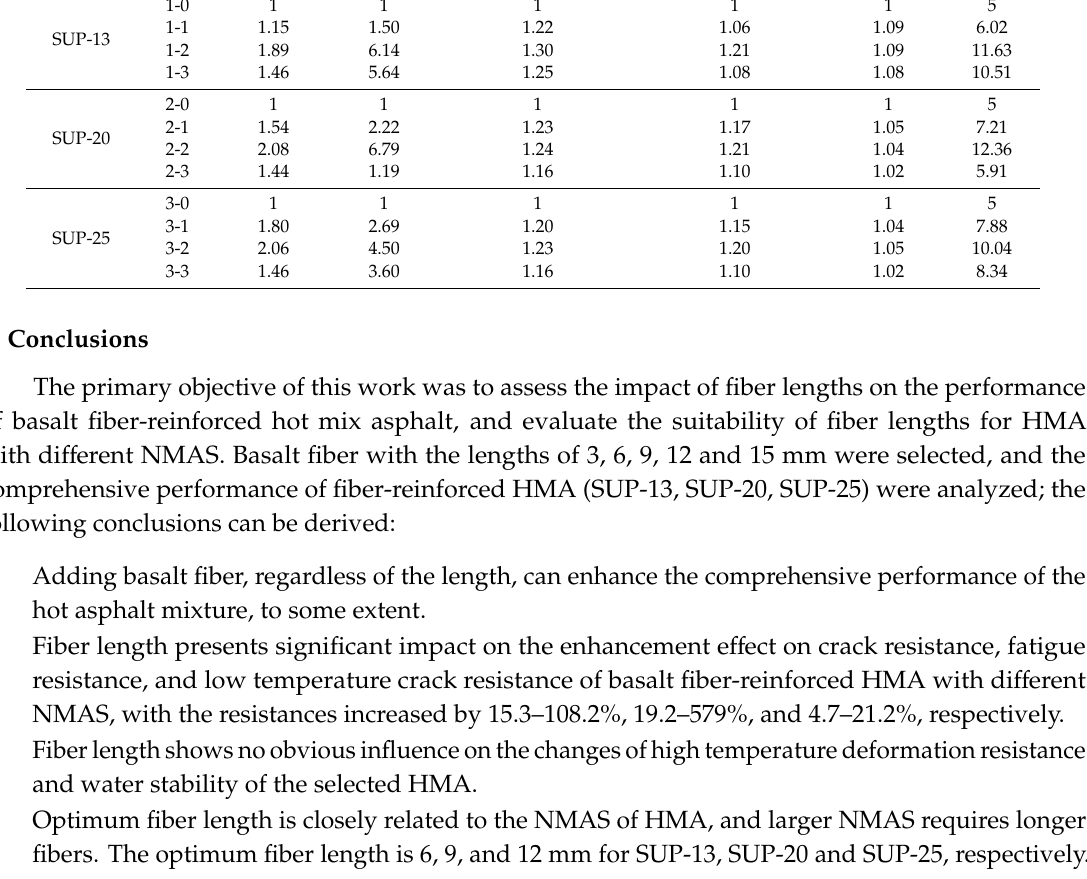
Table S1: IDEAL cracking test results; Table S2: Four-point bending beam fatigue test results; Table S3: Wheel tracking and uniaxial penetration test results; Table S4: Low temperature bending beam test results; Table S5: Freeze-thaw splitting test